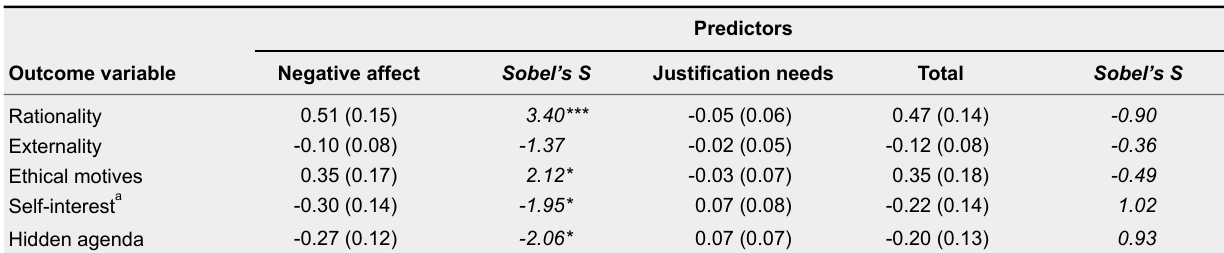
Bootstrapped Estimates of (Unstandardized) Indirect Effects (and Standard Errors) of Position to the Status Quo on the Dependent Variables Through the Mediators (ab Paths), and Sobel Statistics (Study 3, N =